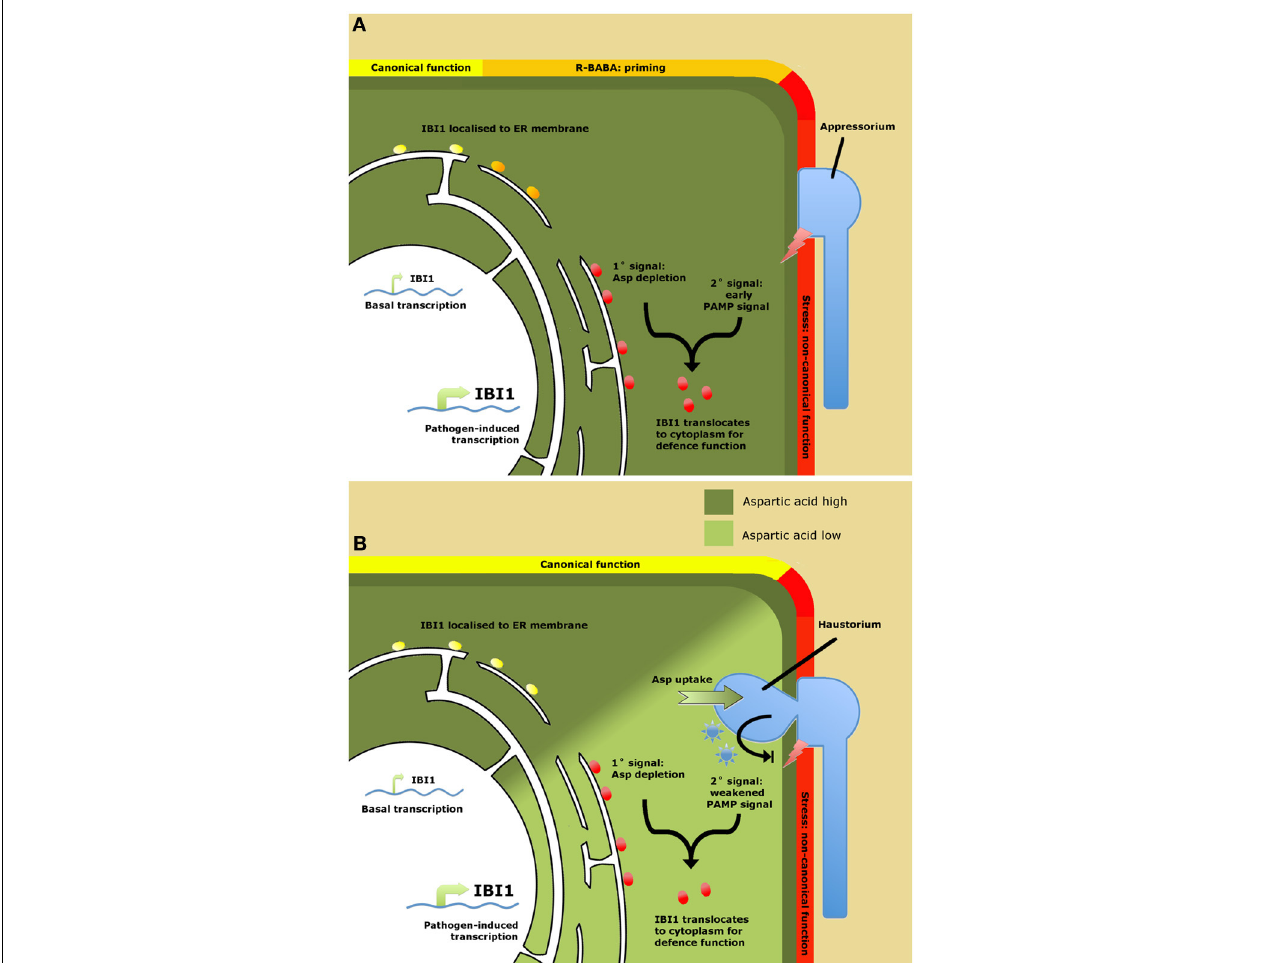
FIGURE 1 | Model of IBI1 as a regulator of BABA-induced resistance (A) and as a “depleted-self sensor” in basal resistance (B). (A) Role of IBI1in BABA-induced resistance (BABA-IR). Binding of R-BABA to ER-localized IBI1 protein (yellow circles) deprives the protein of canonical aspartyl-tRNA synthetase (AspRS) activity, which “primes” the protein’s non-canonical defense activity against pathogen attack (orange circles). Detection of pathogen-associated molecular patterns (PAMPs) during the early stages of pathogen infection boosts IBI1 gene transcription and triggers translocation of IBI1 to the cytosol, where it activates defense activity through interaction with